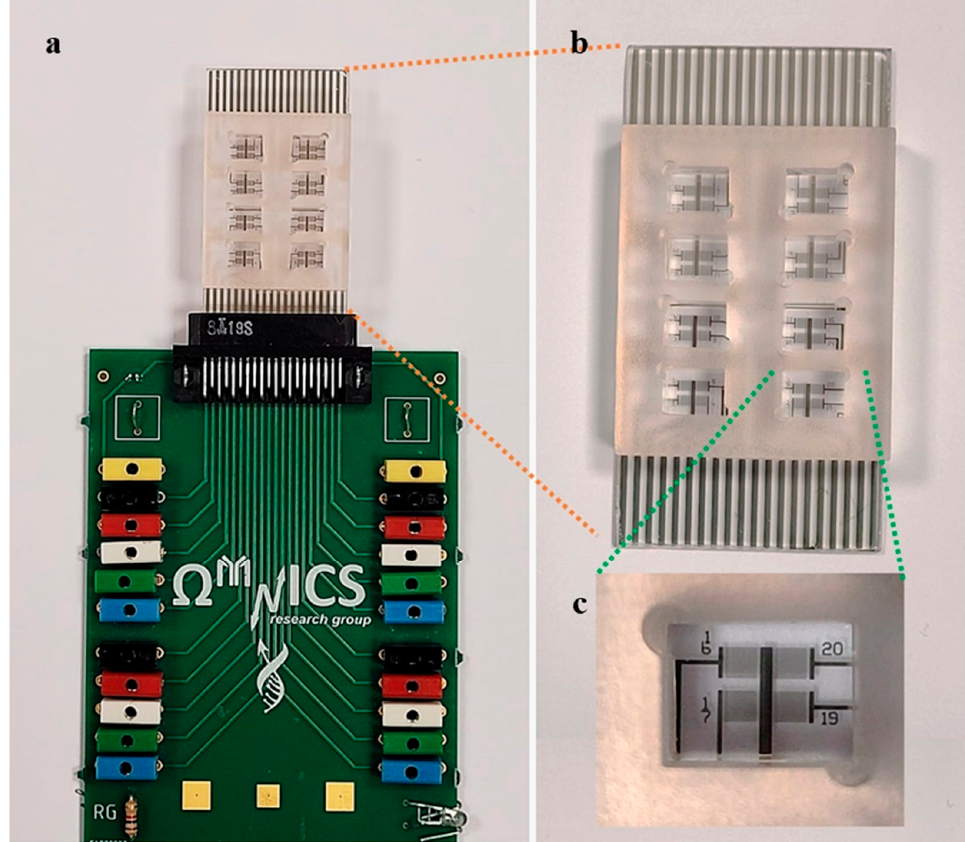
Figure 1. ( a ) EIS sensor with IDT electrodes and 3D resin chamber connected to the printed circuit board; ( b ) details of the EIS sensor device in which the electrodes for external connections are visible on the bottom and on the top of the device; and ( c ) enlargement of a sensor area in which a common reference and four signal pins are clearly visible.